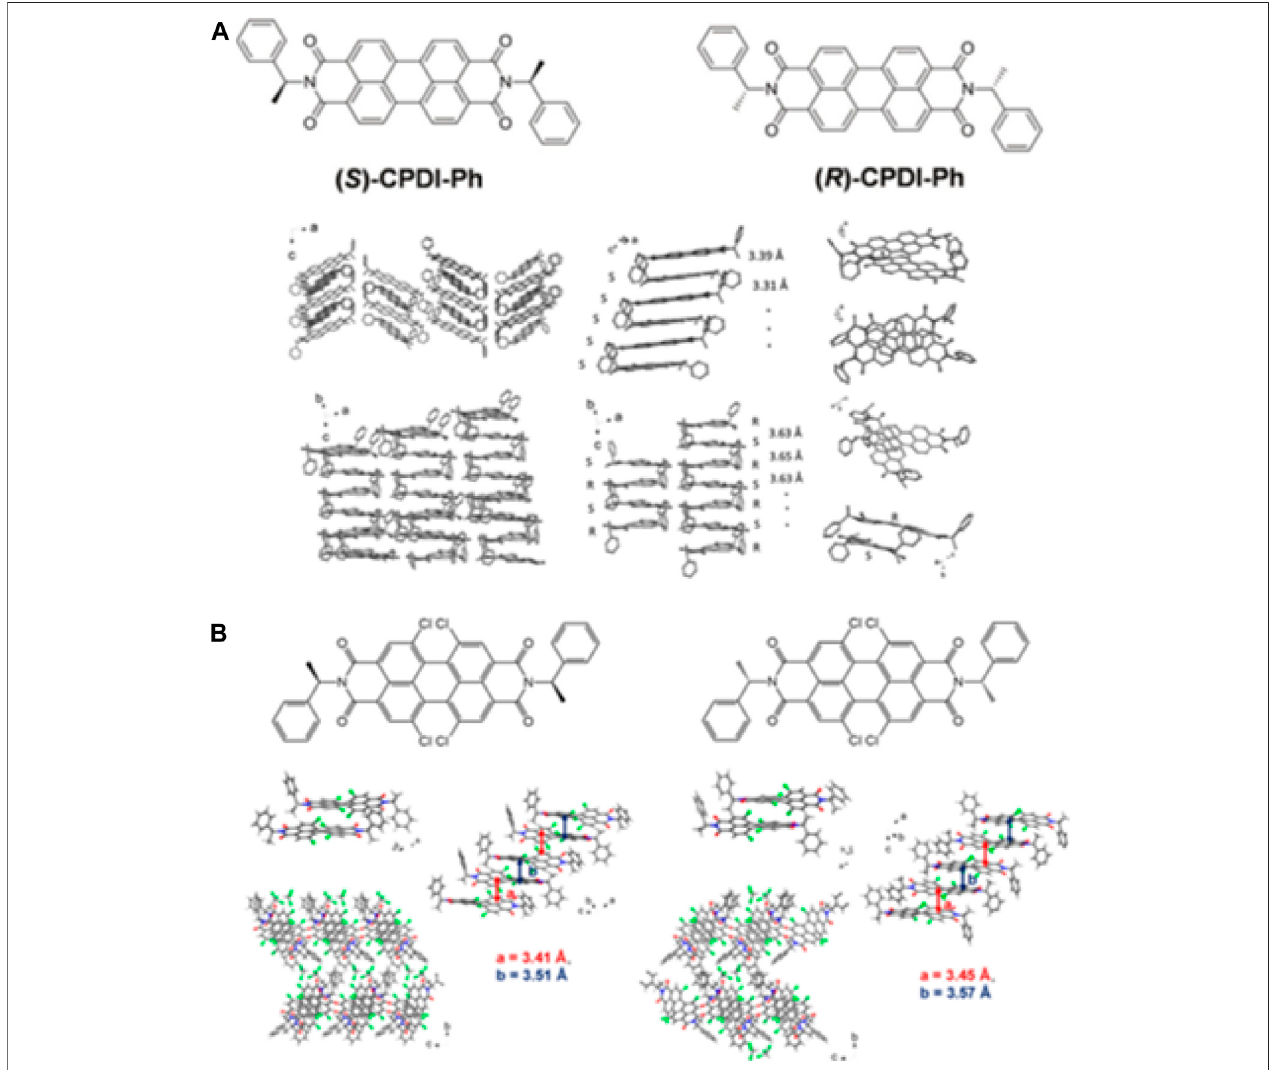
FIGURE 4 | (A) Chemical structure of ( S )-CPDI-Ph and ( R )-CPDI-Ph and crystal structure of homochiral ( S )-CPDI-Ph NWs and heterochiral (Rac)-CPDI-Ph NWs (Shang et al., 2017). Reproduced with permission. Copyright 2015, Wiley-VCH. (B) Chemical structure of ( R )-CLCPDI-Ph and ( S )-CLCPDI-Ph and crystal structure of ( S )-CLCPDI-Ph-CF and ( R )-CLCPDI-Ph-CF (Shang et al., 2020). Reproduced with permission. Copyright 2020, American Chemical